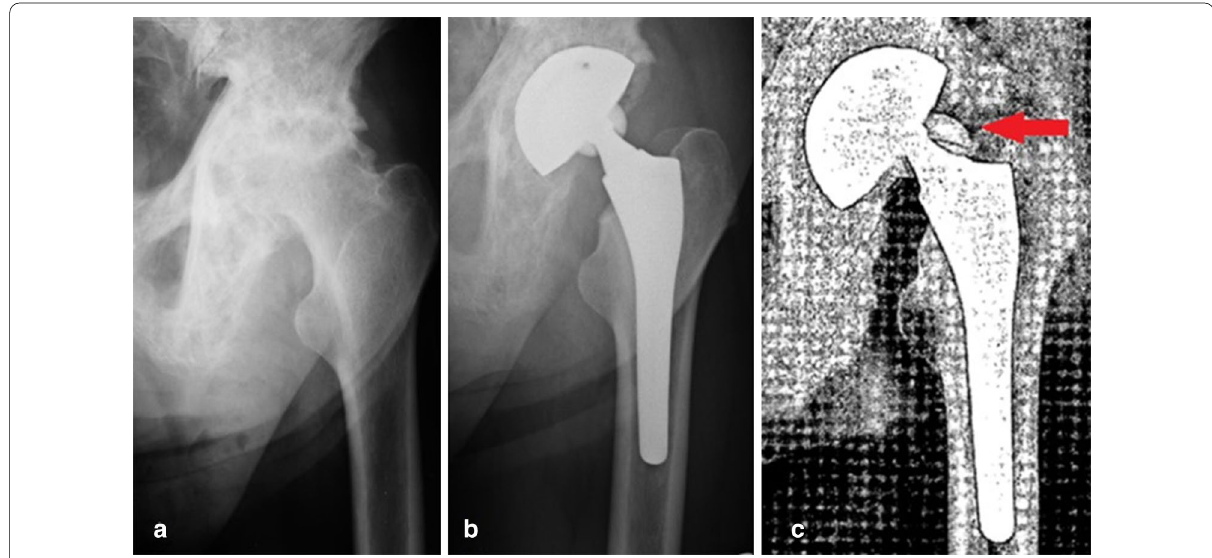
Fig. 4 a Pre-operative anteroposterior X-ray of the left hip of a man who was 76 years old at the time of surgery, showing arthrosis secondary to Paget’s disease affecting the upper femur; b post-operative radiograph: cementless THA; c anteroposterior view of the pelvis after traumatic ceramic head fracture occurred 64 months after